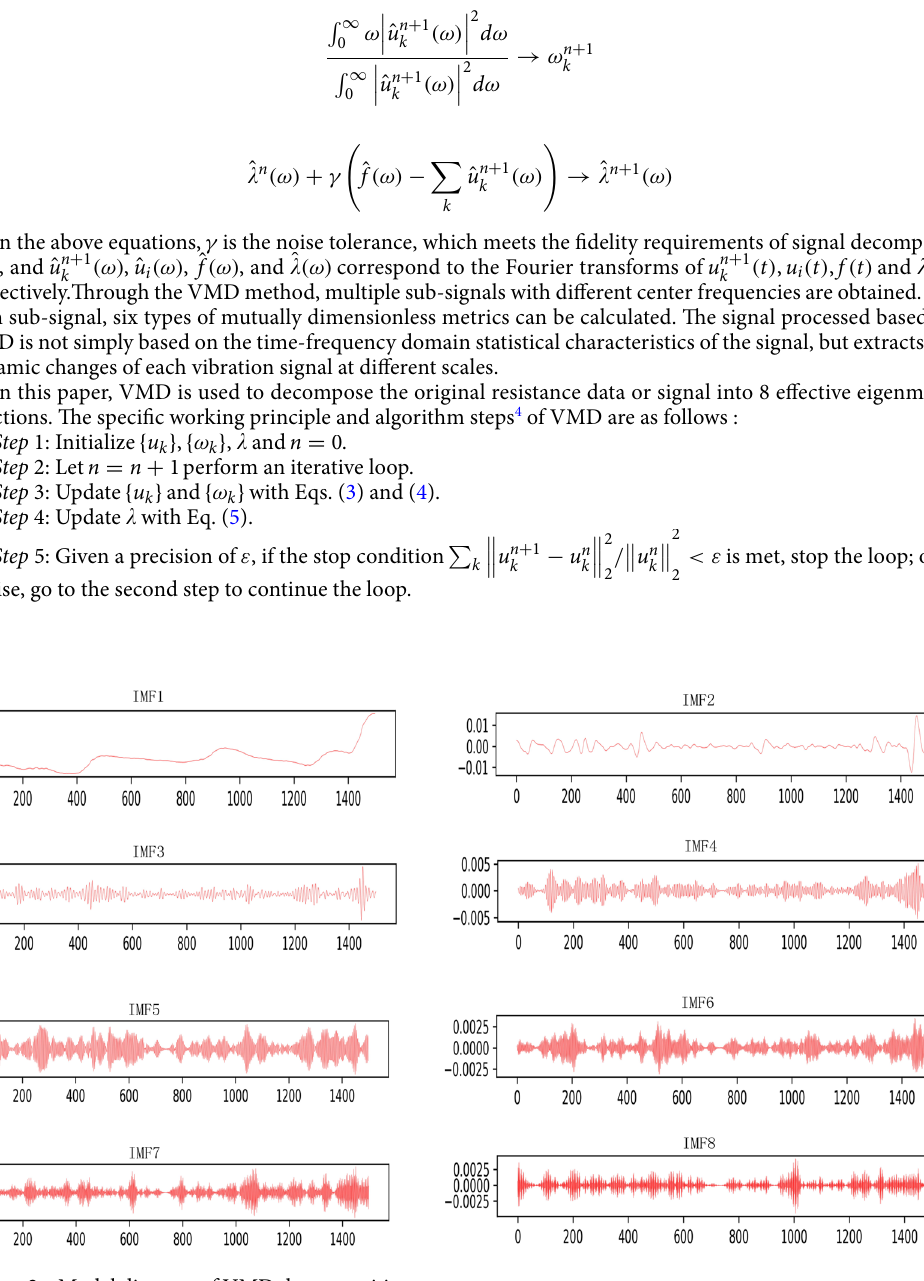
Figure 2. Modal diagram of VMD